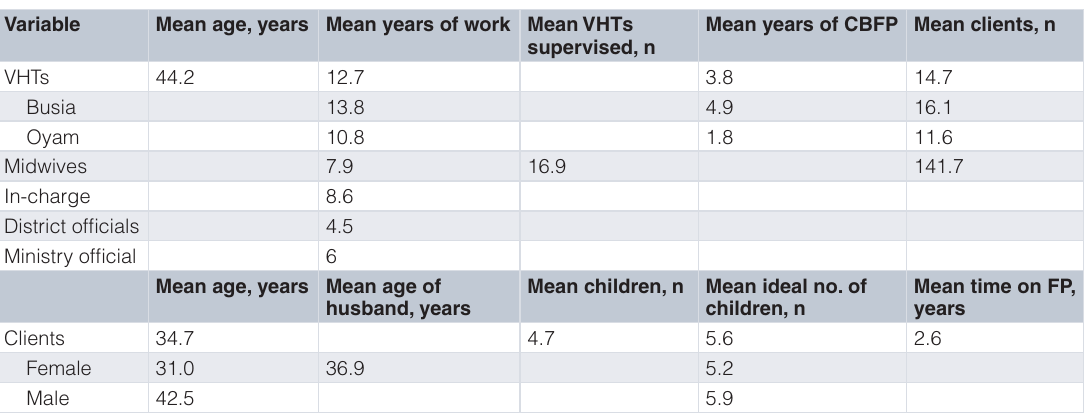
Table 2. Characteristics of respondents.